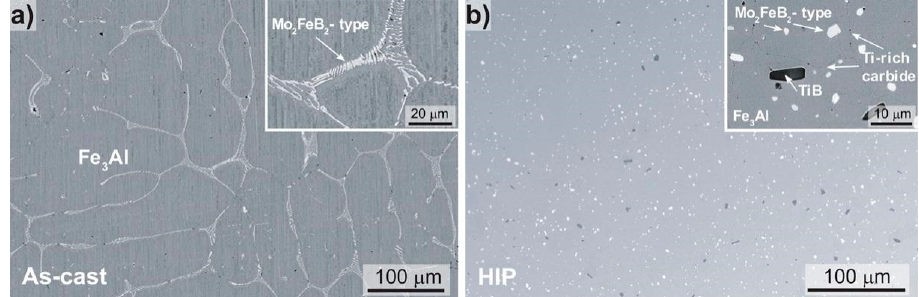
Figure 2. Scanning electron microscope (SEM) images (back-scattered electron (BSE)-mode) of the microstructure of the Fe-Al-Mo-Ti-B alloy in the ( a ) as-cast (Fe-25.7Al-2.0Mo-0.6Ti-1.3B, in at. %)